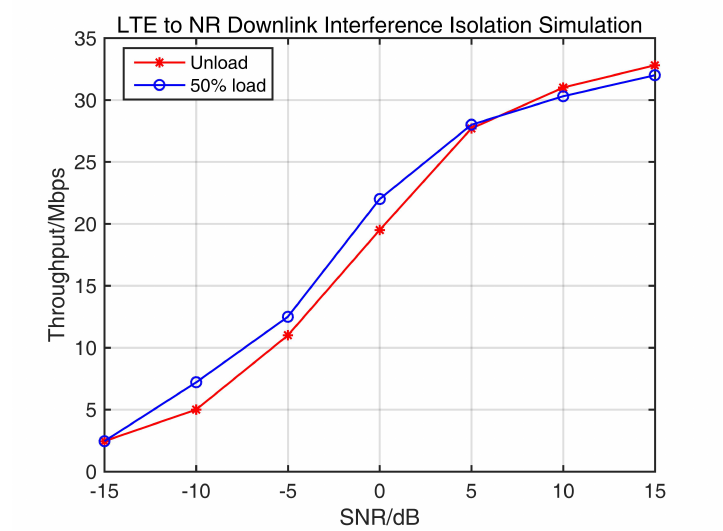
Figure 8. Simulation results of buffer